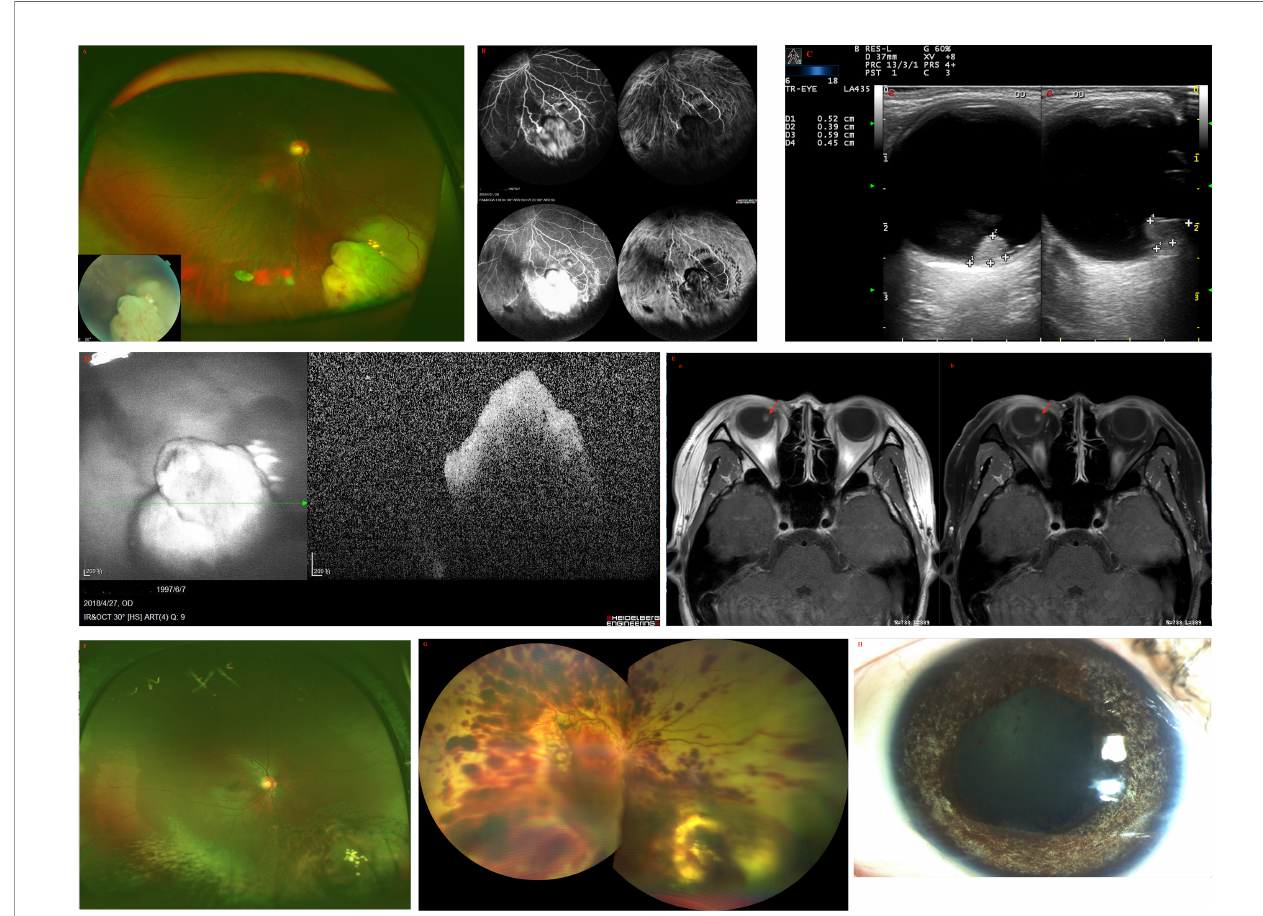
FIGURE 1 | (A) Fundus examination of the right eye of patient 1 revealed a large white dome-shaped retinal tumor in the inferonasal quadrant with feeding vessels and a few vitreous cellularities. (B) On fundus fl uorescein angiography (FA), multiple areas of the tumor displayed mottled hyper fl uorescence in the early phase and hyper fl uorescence with intense leakage in the late phase. On indocyanine green angiography (ICGA), the tumor showed hypo fl uorescence during all stages. (C) Color Doppler imaging (CDI) revealed a pedunculated mass with inconsistent re fl ectivity of moderate-intensity and no choroidal excavation, as well as arterial blood signals in the tumor. The size of the elevated lesion was 5.2 × 3.9 × 5.9 mm 3 . (D) Optical coherence tomography (OCT) revealed that the tumor had a sloped dome-shaped elevation, with a hyperre fl ective anterior surface and vitreous seeds, and normal macular fovea. (E) MRI revealed that the tumor was far from the optic nerve in the right globe, demonstrating a slightly higher hyperintensity (arrow) than vitreous in (a) axial T1-weighted MRI, hypointensity (arrow) in (b) axial T2-weighted MRI, and moderate enhancement of the tumor in axial contrast-enhanced T1-weighted, fat-saturated MRI. (F) At the last follow-up 15 months after the last combination treatment, the retinoblastoma demonstrated complete regression into a partially calci fi ed scar. (G) One day after IV-Melphalan, intravitreal melphalan-hemorrhagic retinopathy toxicity occurred. (H) The patient showed signs of iris atrophy and eventually developed phthisis